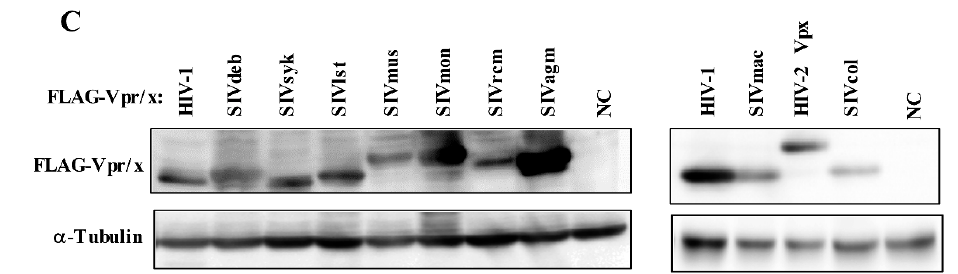
Figure 1. Phylogeny of 96 primate lentiviruses Vprs and multiple alignment and expression of Vpr/x selected from representative strains. ( A ) Phylogenetic tree was constructed from 96 full-length HIV/SIV Vpr amino acid sequences via neighbor-joining methods using 1000 bootstrap replicates. Scale bars depict genetic distance. Representative Vprs from 10 different lineages were selected as later alignment candidates. These originated from viruses belonging to three different groups containing HIV-1 type (HIV-1, SIVmus and SIVmon), prototype (SIVdeb, SIVsyk, SIVlst, SIVagm, and SIVcol) and HIV-2 type (SIVmac, SIVrcm and HIV-2), which are shown in blue, green, and orange, respectively. ( B ) Sequence alignments of candidate HIV/SIV Vprs and HIV-2 Vpx. HIV-1 Vpr was chosen as standard sequence and HIV-2 Vpx as outgroup control. Alignments of HIV/SIV Vpr/x showed sequence and structural conservation, characterized by three α -helices and a potential zinc-binding motif among lentiviruses Vpr/x, indicated by the reference structure, HIV-1 NL4-3, at the top of alignments. ( C ) Expression of 10 HIV/SIV Vprs and 1 HIV-2 Vpx. HEK293T cells were transfected with pcDNA3.1 that encoded 3 × FLAG-tagged HIV/SIV Vpr/x proteins, or the control pcDNA3.1/3 × FLAG (NC: negative control). Transfected cells were harvested at 48 h following transfection and lysates with the equal protein amounts were subjected to western blotting. Positions of Vpr and α -Tubulin are indicated.